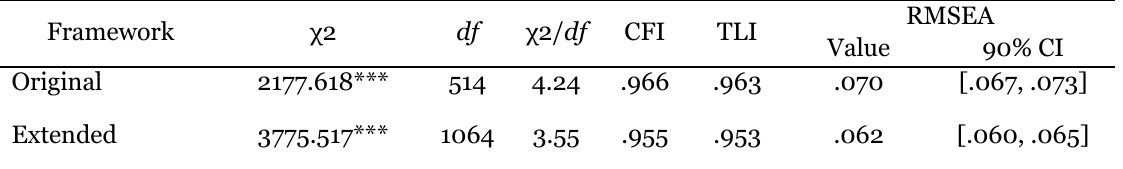
Results of Second-Order Confirmatory Factor Analysis for the Two Frameworks Framework χ2